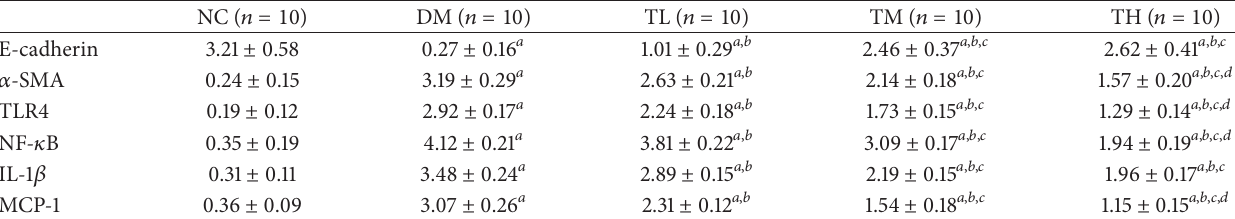
NC: normal control; DM: diabetic rats without drug treatment; TL: low-dose TGT (1mg/kg/day); TM: medium-dose TGT (3mg/kg/day); TH: high-dose TGT (6mg/kg/day). a 𝑝 < 0 . 05 versus NC group, b 𝑝 < 0 . 05 versus DM group, c 𝑝 < 0 . 05 versus TL group, and d 𝑝 < 0 . 05 versus TM